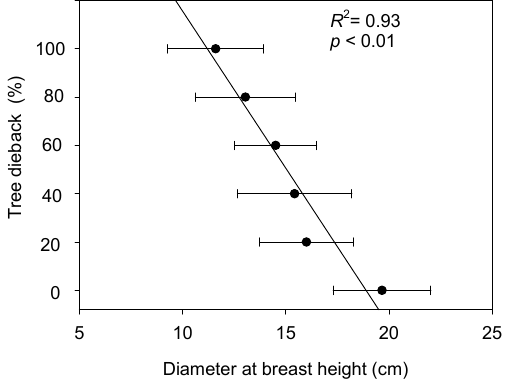
Figure 4. Relationship between diameter at breast height and dieback rate.